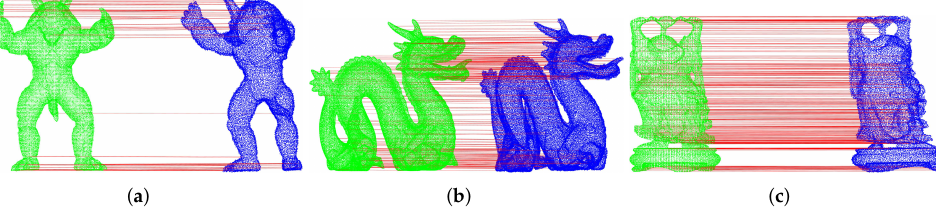
Figure 12. Examples of matching results between models and Gaussian noise models. ( a ) Cor- responding key point pairs in Armadillo. ( b ) Corresponding key point pairs in Asian Dragon. ( c ) Corresponding key point pairs in Happy